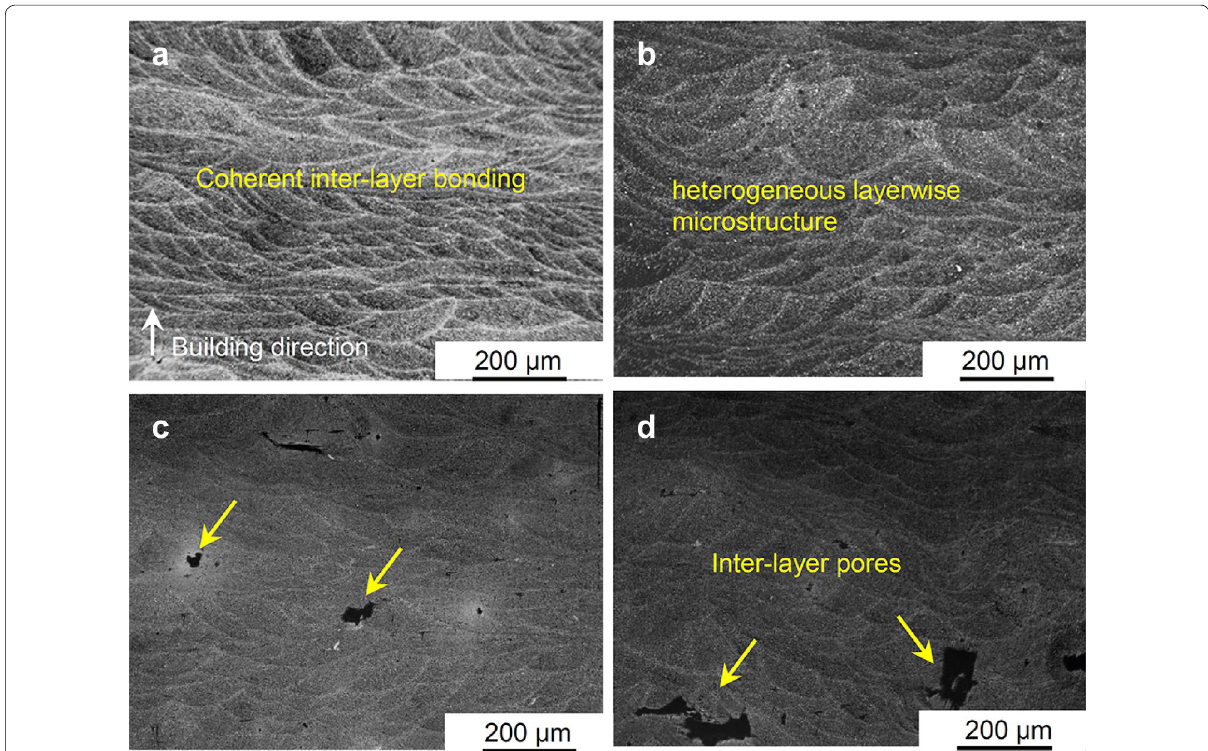
Figure 5 Morphologies of the molten pool on cross sections of SLM-processed TiB 2 /AlSi10Mg composite samples at different parameters ( P W): a v